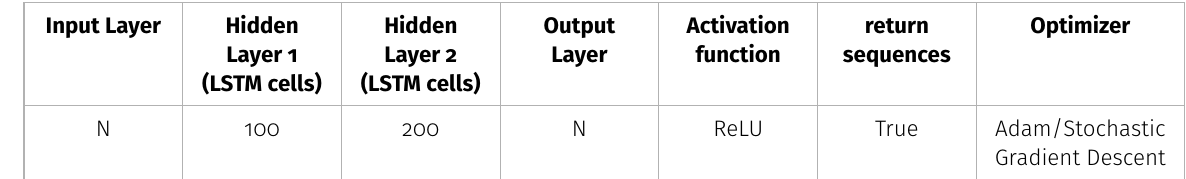
Table I. LSTM models